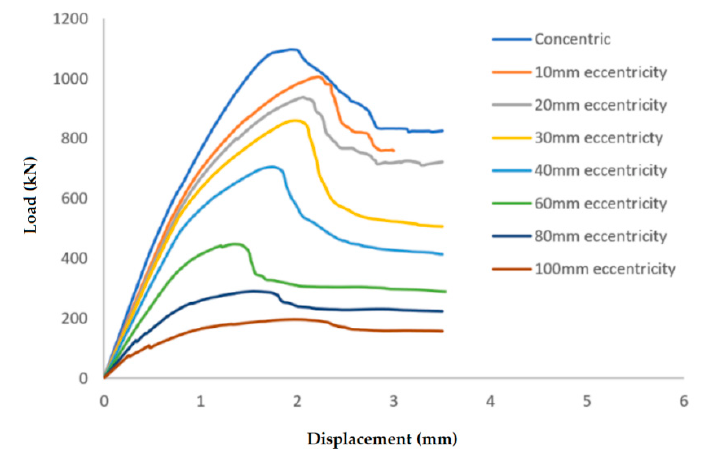
Figure 12. Load vs. displacement results for columns in Group 1, at the 1% reinforcement ratio.